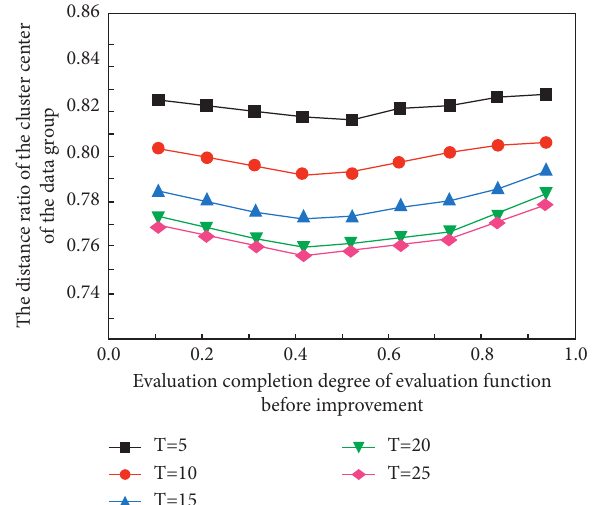
Figure 4: The simulation analysis result of the evaluation function on the data under different threshold settings before the improvement.